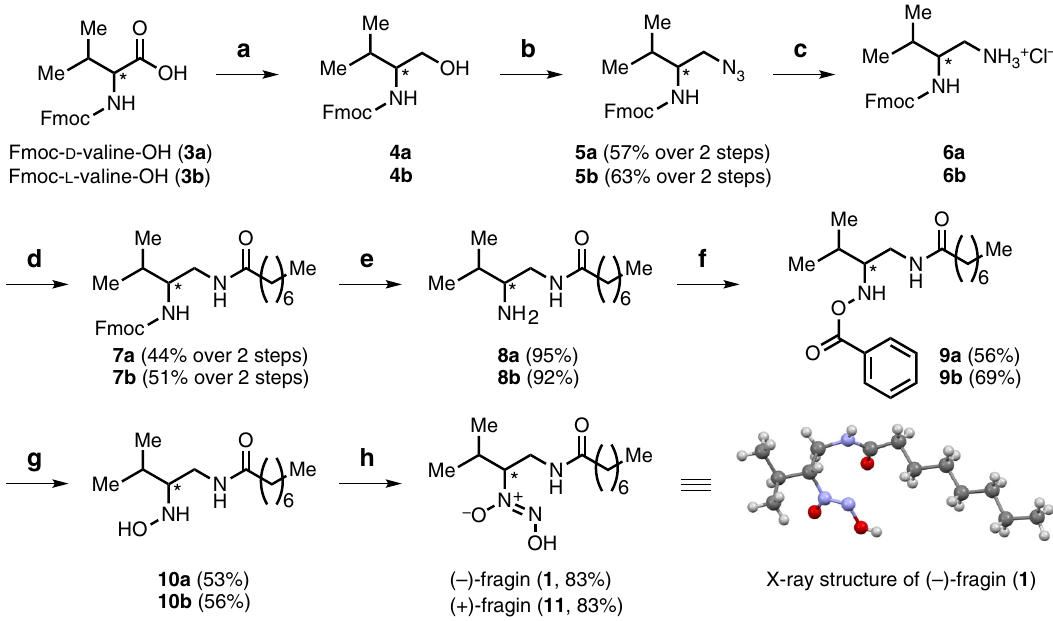
Fig. 3 Enantioselective total synthesis of ( − )-fragin ( 1 ) and ( + )-fragin ( 11 ), and X-ray crystal structure of isolated ( − )-( R )-fragin ( 1 ). Color code: blue = nitrogen; gray = carbon; red = oxygen; white = hydrogen. a Isobutyl chloroformiate, NaBH 4 , DME, 1.5 h, – 15 °C; b PPh 3 , DEAD, DPPA, THF, 0 °C to RT, 10 h; c Pd/C Et 3 SiH, MeOH/CHCl 3 , RT, 14 h; d octanoyl chloride, DIPEA, DMAP, 0 °C to RT, 35 h; e AlCl 3 , toluene, RT, 4 h; f dibenzoylperoxide, K 2 HPO 4 , THF, RT, 21.5h; g N 2 H 4 x H 2 O, EtOH, RT, 2.5 h; h isopentyl nitrite, NH 3(g) , EtOH, RT, 0.5